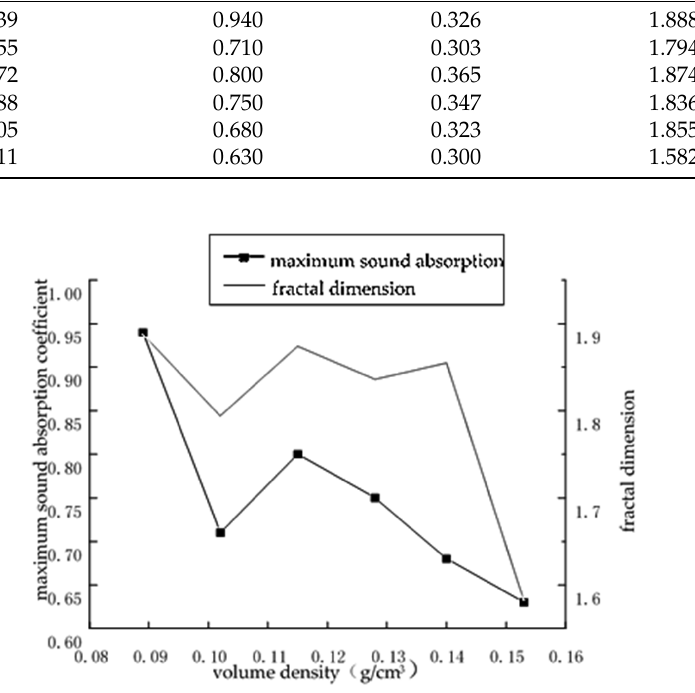
Figure 8. Relationship between fractal dimension and maximum sound-absorption coefficient of samples at different volumetric densities .